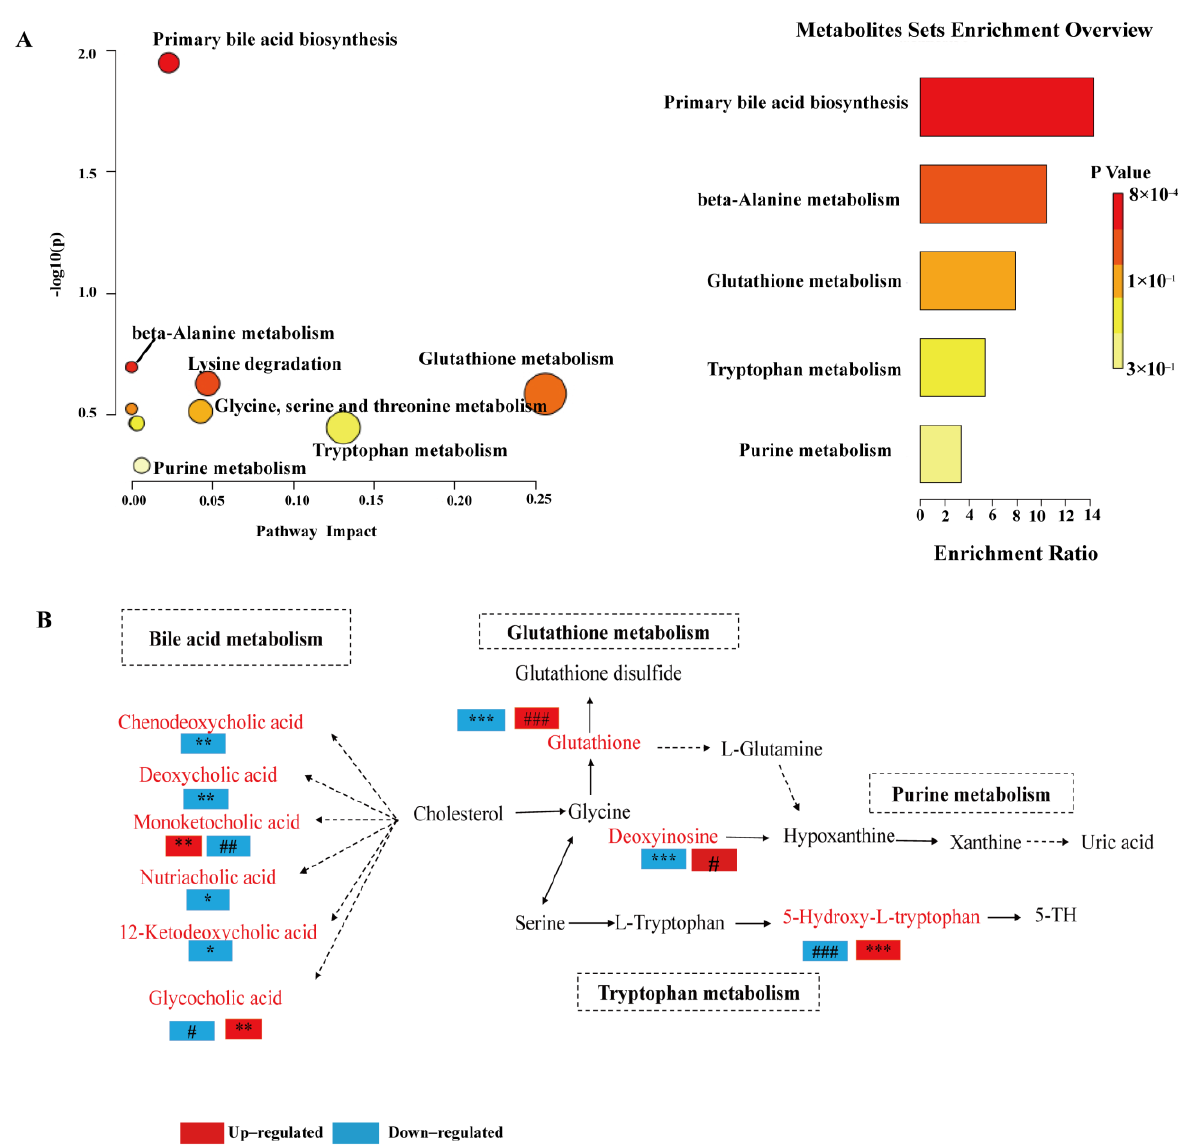
Figure 6. Metabolic pathway analysis ( A ) Summary of pathway analysis for potential biomarkers with MetaboAnalyst5.0. Each point represents a metabolic pathway. ( B ) Metabolic pathway networks related to the differential metabolites. Red text indicates differential metabolites. Dashed lines: indirect relationships, solid lines: direct relationships.